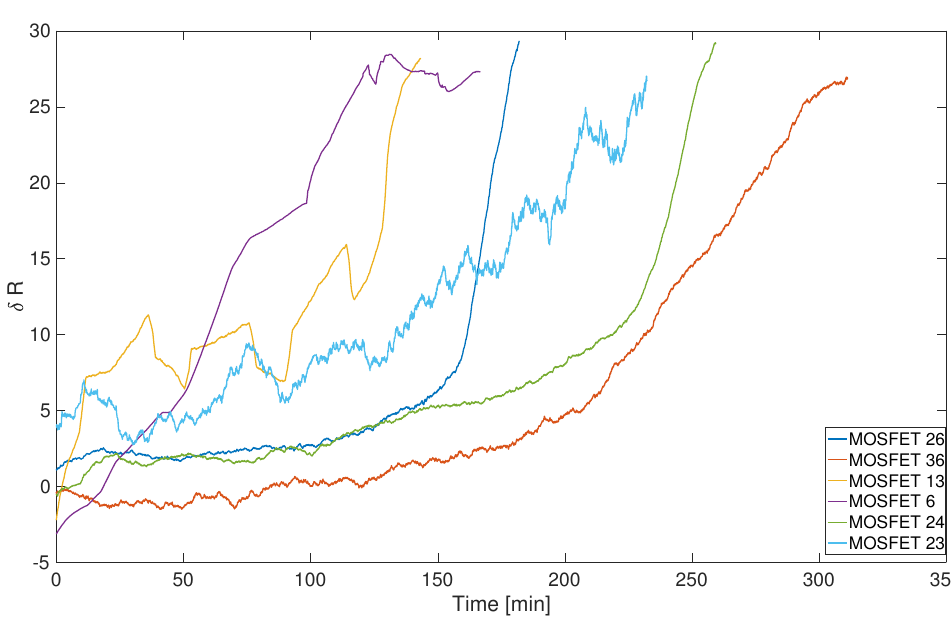
Figure 12. Exemplary filtered degradation signals for MOSFETs 6, 13, 23, 24, 26 and